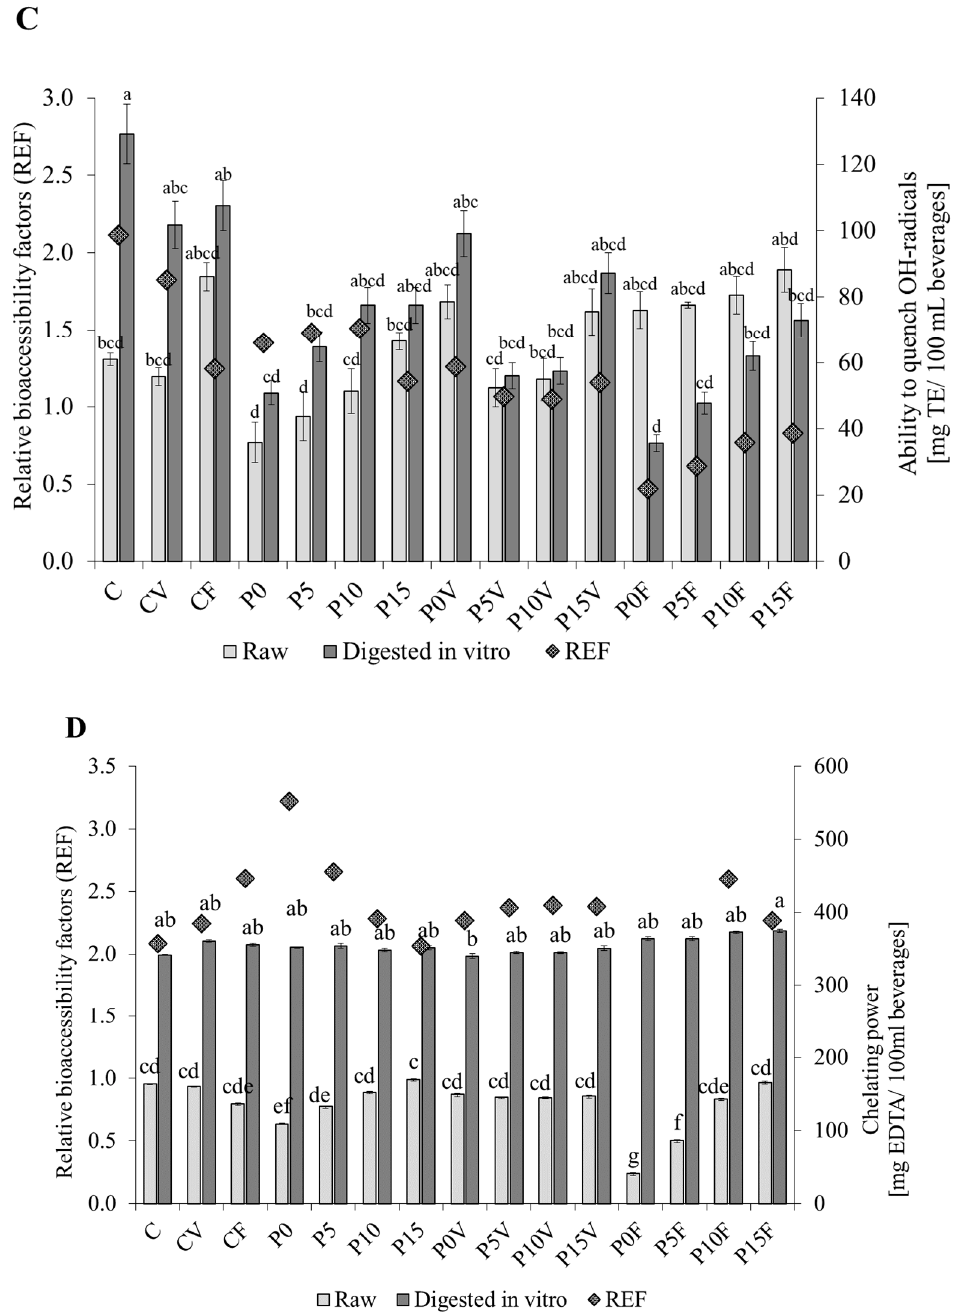
Figure 1. Reducing properties of the powdered beverages. ( A )—Reducing power; ( B )—Ability to quench ABTS radicals; ( C )—Ability to quench OH-radicals; ( D )—Chelating power. C—beverages based on lentil sprouts; P—beverages based on lentil proteins; V—lyophilized parsley and broccoli sprouts; F—lyophilized strawberry and raspberry; 0–15—amounts of flaxseeds gum (%). REF—the relative bioaccessibility factor; TE—Trolox equivalents. Means (±SD) followed by different letters are significantly different ( n = 9; p ≤ 0.05).